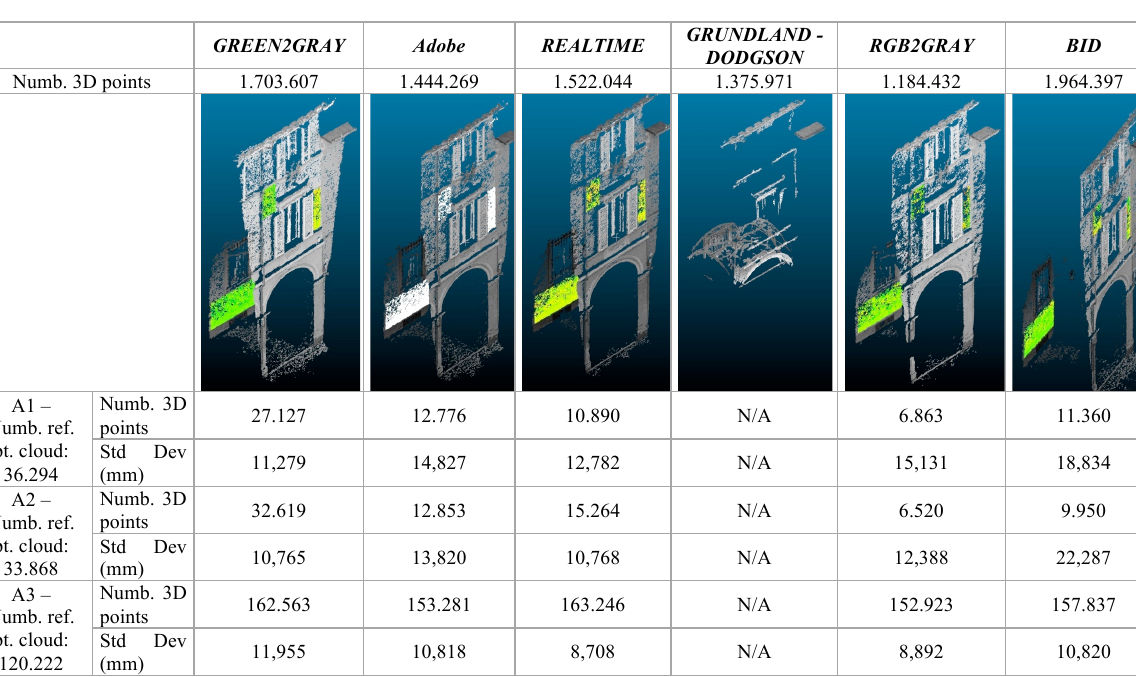
Table 4: Bundle adjustment (BA) results of the RGB to GRAY methods applied to the enhanced dataset. GREEN2GRAY Adobe